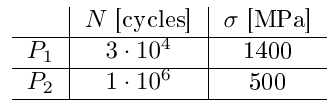
Table 4: S(cid:21)N curve parameters using two points ( P 1 and P 2 can be seen in Figure 4).